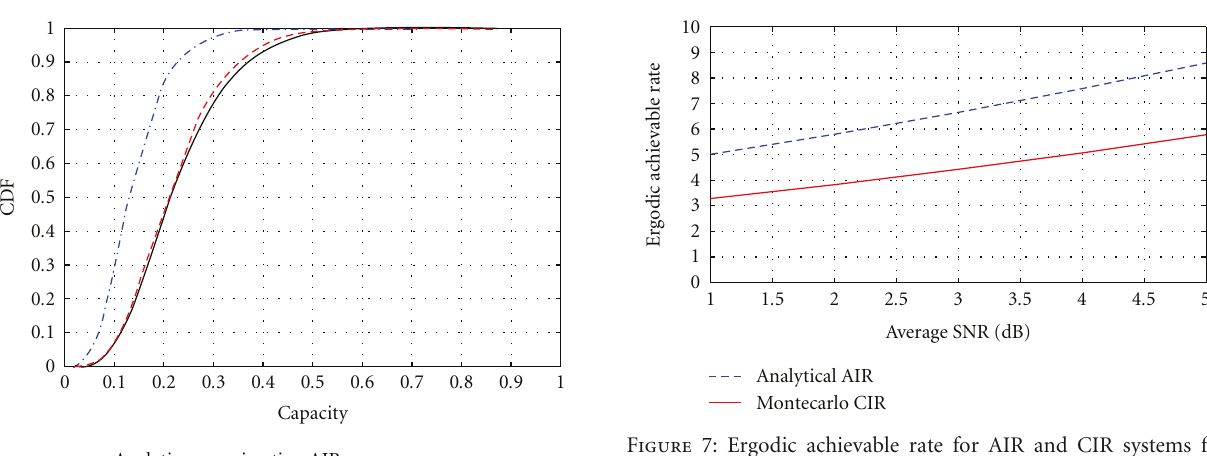
Figure 7: Ergodic achievable rate for AIR and CIR systems for a Network Coding group with M = 5 nodes. The high values of the rates are due to NC gain. We see how AIR system gains about 2bits/sec/Hz in all the considered SNR